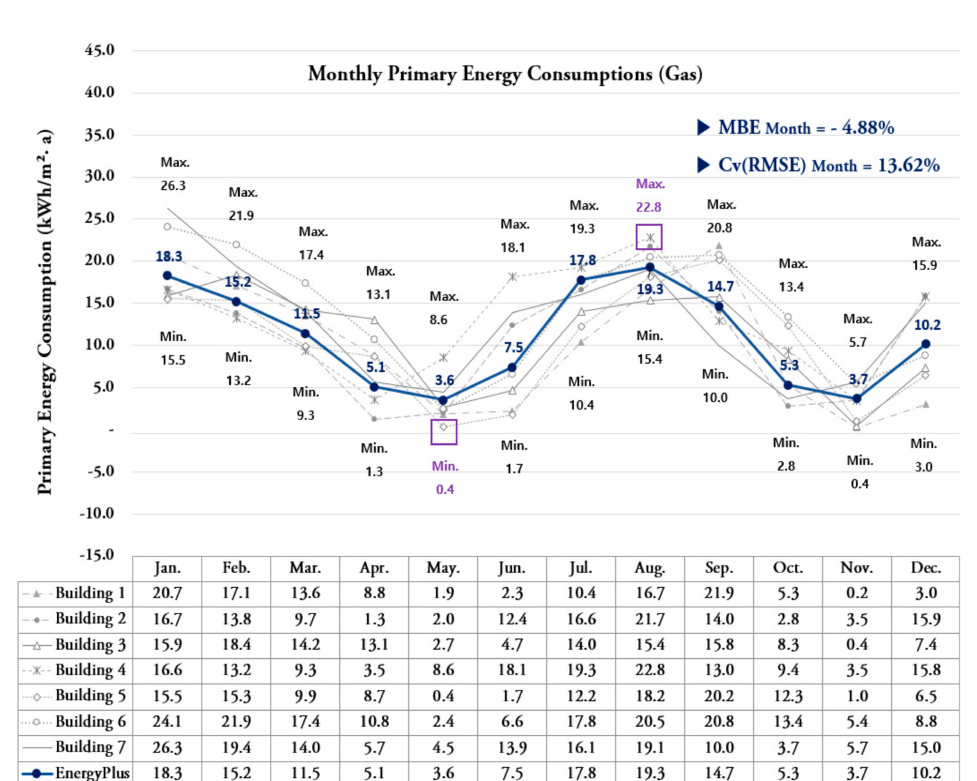
Figure 5. Comparison of electrical measurement data and base model simulation data.